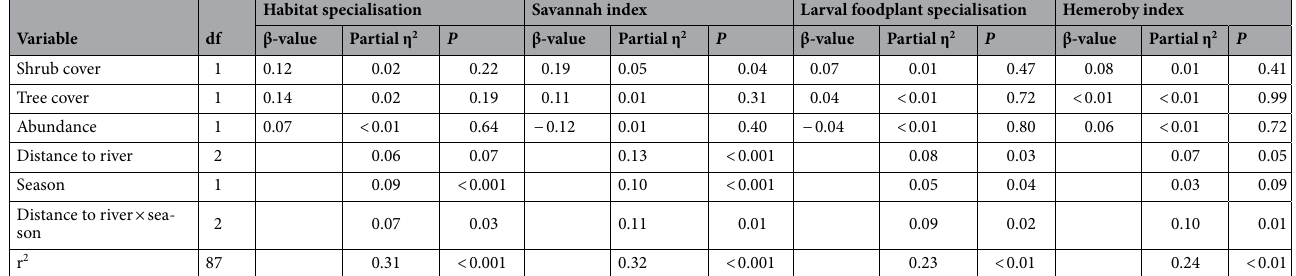
Table 4. Differences identified with general linear modelling between transect distance from the river and season with respect to important butterfly habitat traits. Note that habitat conditions only marginally influenced trait expression. Number of records (abundance) served as metric covariate.